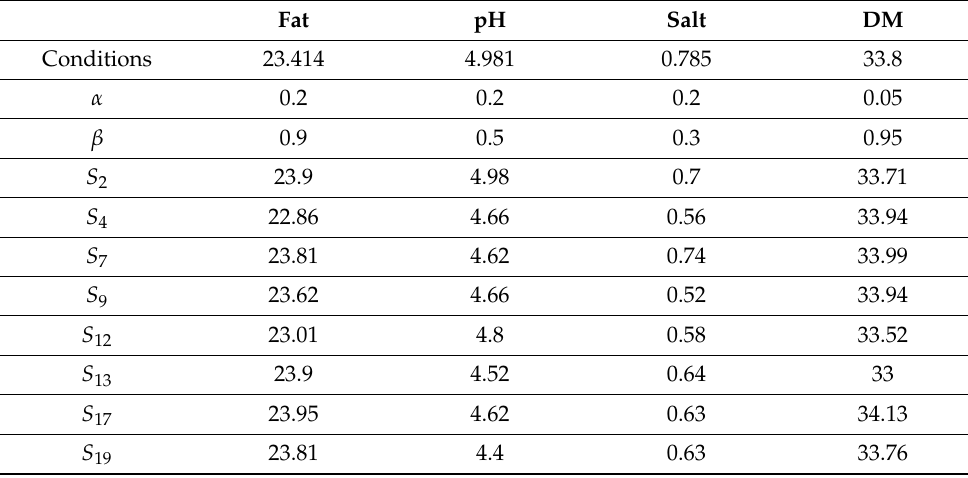
Table 13. Suppliers’ evaluations with the four conditions of fat, pH, salt, and